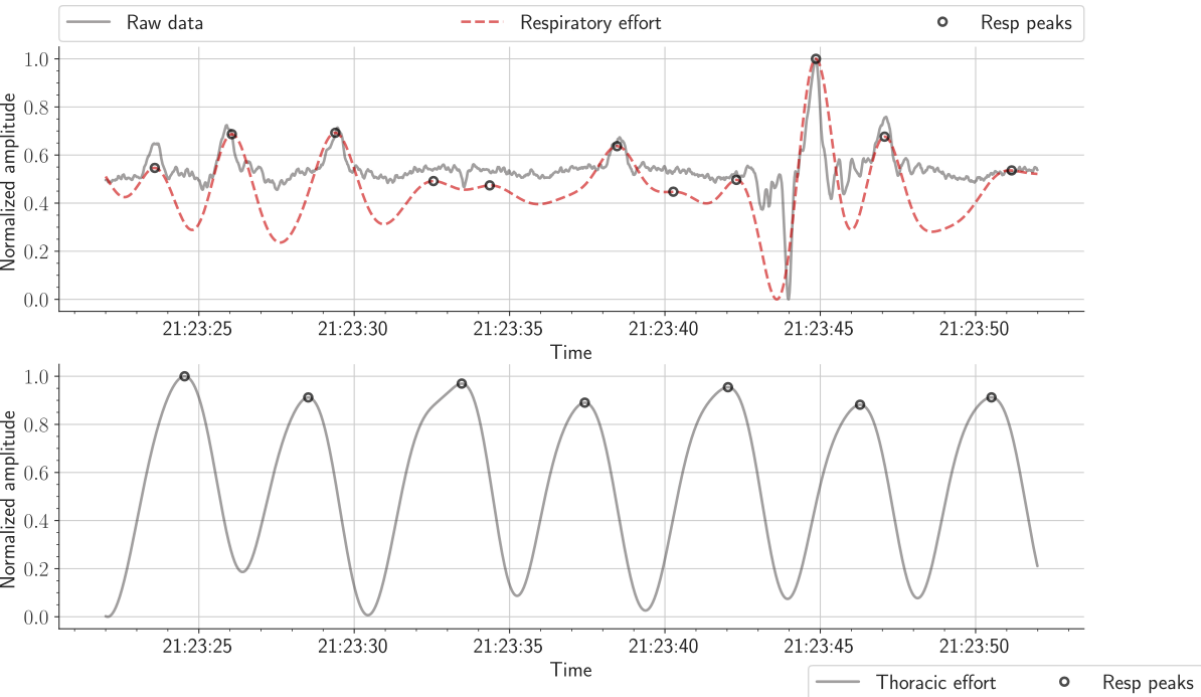
Figure 16. The first row displays a 30-second raw signal plus the respiratory effort signal for patient 6. The second row shows the equivalent thoracic belt signal.